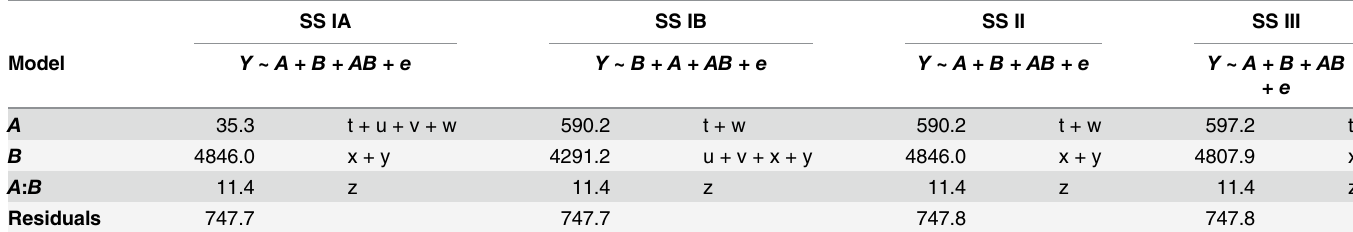
Table 3. The SS of Example data, using (-1, 1) coding for analysis.